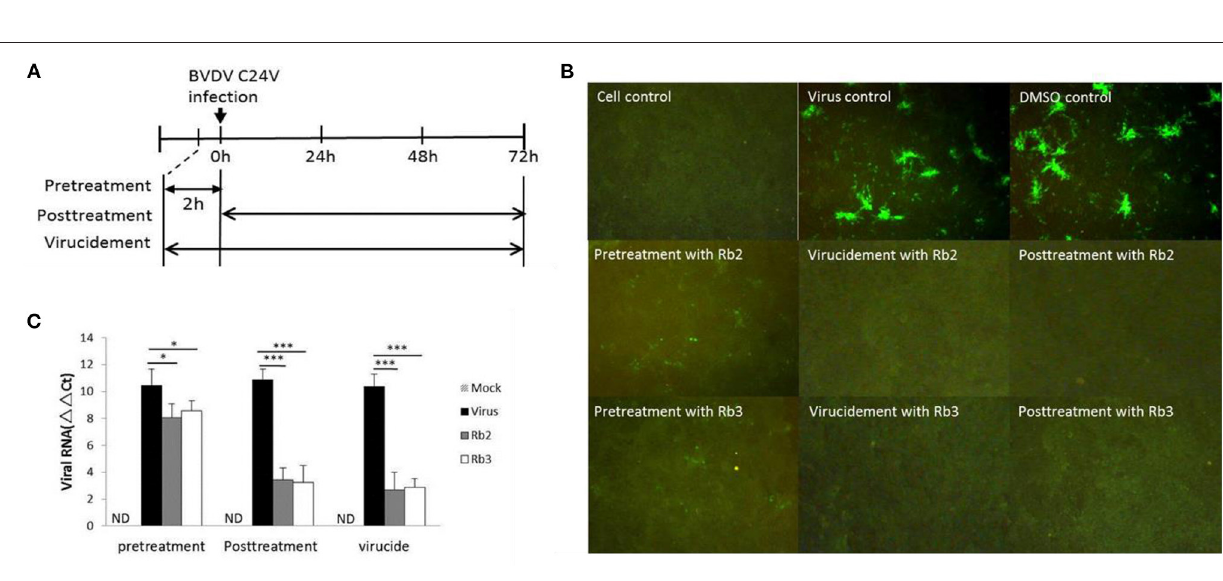
FIGURE 6 | Stage of antiviral activity against cpBVDV C24V by ginsenoside Rb2 and Rb3. (A) A schematic diagram describing the experimental scheme for measuring the stage at which ginsenoside exerts its effects. (B) The FA result of plaque reduction assays. (C) Changes in viral RNA level. * p < 0.05; *** p < 0.001.